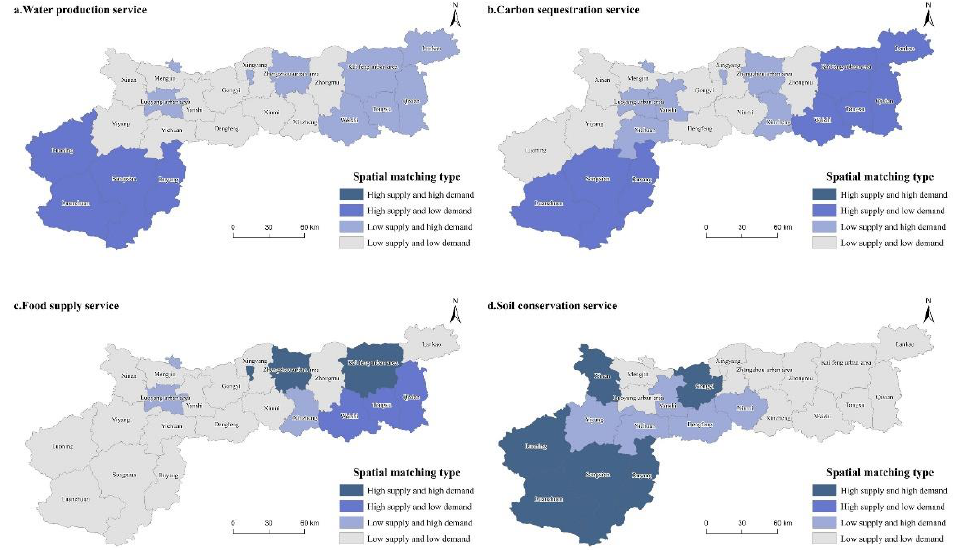
Figure 5. Supply-demand matching types of ( a ) water production service, ( b ) carbon sequestration service, ( c ) food supply service, and ( d ) soil conservation service in the ZKL urban agglomeration.